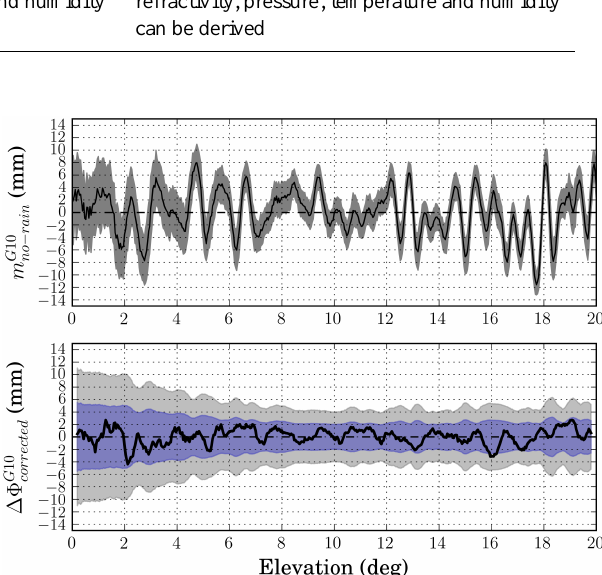
Figure 3. Examples of (top) local multipath pattern after applying ,σ G10 ) , using a total of 132 days de- Eq. (4) for PRN 10 (m G10 no-rain no-rain fined as no-rain days. Notice the large standard deviation at lower elevations and σ G10 of about 2mm at higher elevations. Bottom no-rain ((cid:15)) for 16 April 2014 (black line) after ap- panel: corrected (cid:49)(cid:56) PRN day plying Eq. (5). The 1 and 2 σ thresholds (local multipath standard deviation) are represented in blue and grey, respectively.